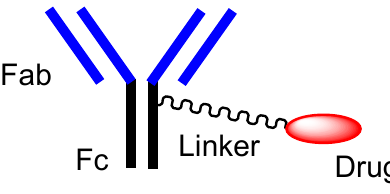
Figure 3. The typical structure of antibody-drug conjugate (ADC).